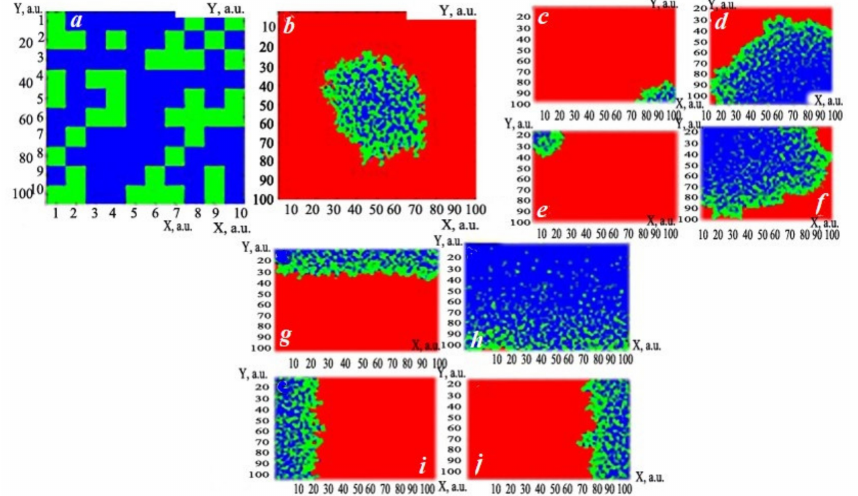
Figure 9. SIR model for seismic wave propagation from sources: S(t) + I(t) + R(t) = const = N (from the number of objects N). Solutions (in arbitrary units) of the trait propagation model by cellular automaton method for β = 0.029, γ = 0.01, T = 100: ( a ) N = 100, S(0) = 10; ( b ) N = 10000, S(0) = 10. Different colors indicate the cell states—from 0 to 2; for β = 0.029, γ = 0.01, N = 10000: ( c ) T = 100, lower-right corner; ( d ) T = 500, lower-right corner; ( e ) T = 100, upper-left corner; ( f ) T = 500, upper-left corner; for β = 0.029, γ = 0.01, N = 10,000: ( g ) T = 100, the upper limit of the computation domain; ( h ) T = 500, the lower limit; ( i ) T = 100, the left border; ( j ) T = 100, the right border. Here, T stands for the relative number of steps in time and specifies the distribution in the uniform grid with step h.